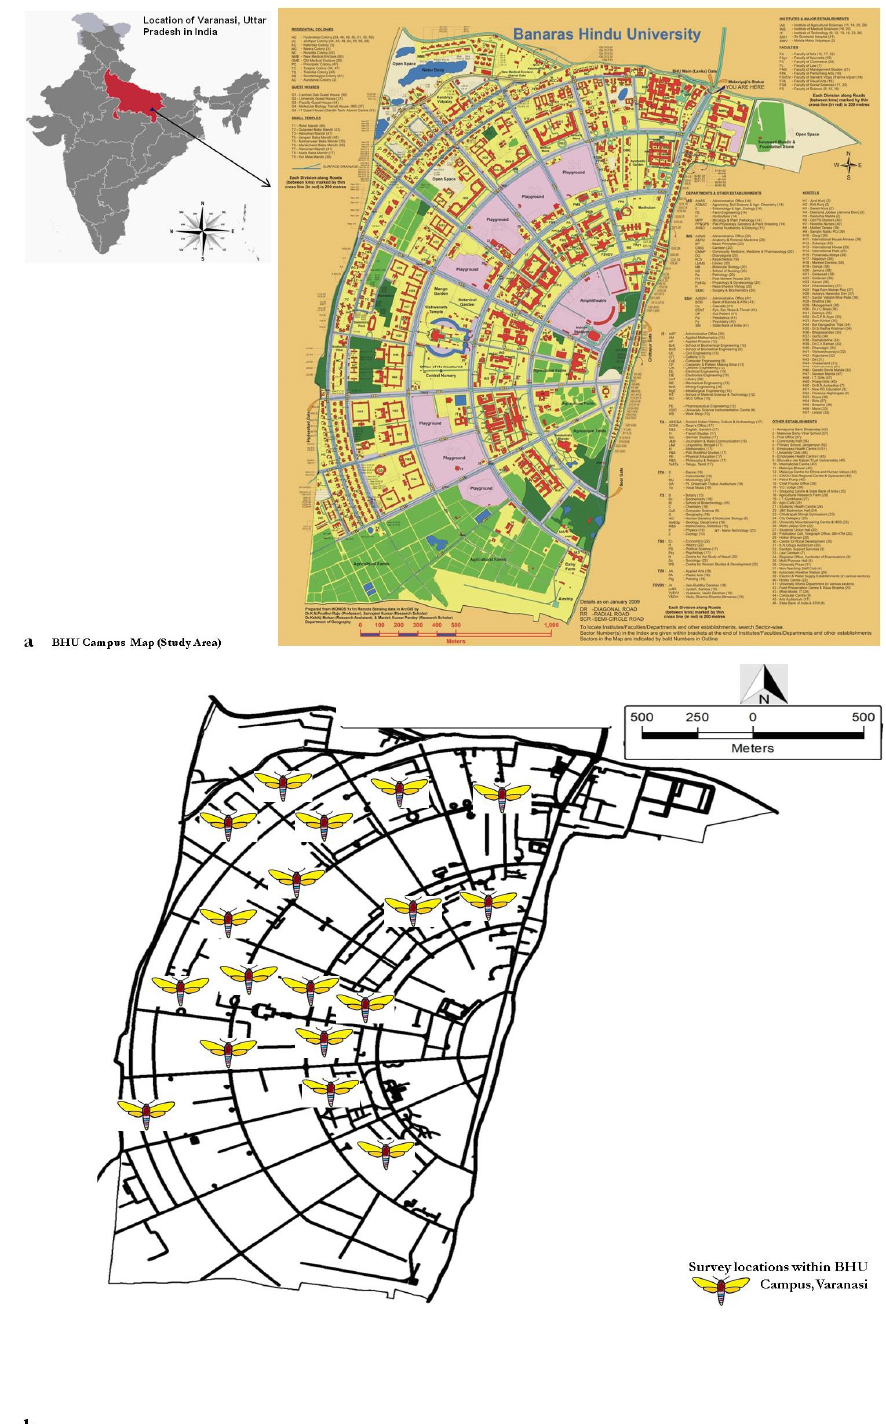
Figure 1. a. Map of BHU campus in Varanasi, Uttar Pradesh, India (Map data: India from Wikipedia; Campus map from the university website). b. Survey locations within BHU campus (Map data: Campus map from Raju et al .,